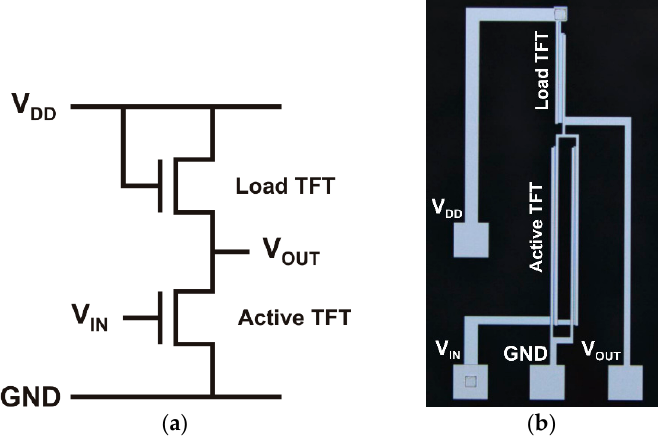
Figure 6. ( a ) Schematic circuit and ( b ) an optical microscope image of an inverter using ZnO nanoparticle TFTs.